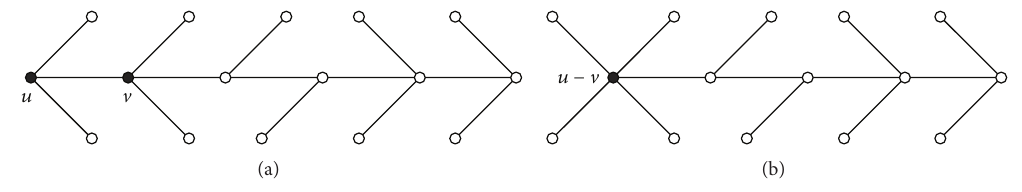
Figure 1: (a) A graph, 𝐺 ; (b) 𝐺/{𝑢, V }